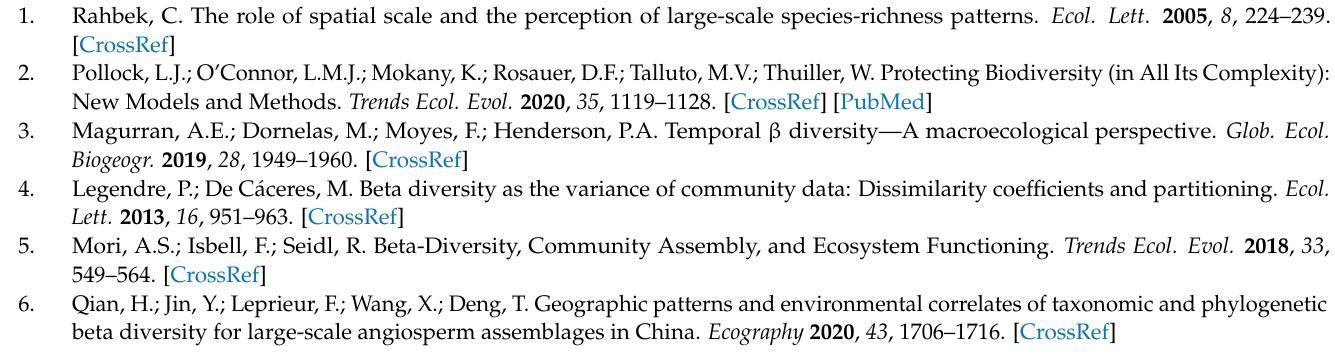
Figure S3: Partial response for 40–60 cm edaphic factors on trees’ GDM; Figure S4: Partial response for 60–100 cm edaphic factors on trees’ GDM; Figure S5: Partial response for 0–20 cm edaphic factors on shrubs’ GDM; Figure S6: Partial response for 20–40 cm edaphic factors on shrubs’ GDM; Figure S7: Partial response for 40–60 cm edaphic factors on shrubs’ GDM; Figure S8: Partial response for 60–100 cm edaphic factors on shrubs’ GDM; Figure S9: Partial response for 0–20 cm edaphic factors on herbs’ GDM; Figure S10: Partial response for 20–40 cm edaphic factors on herbs’ GDM; Figure S11: Partial response for 40–60 cm edaphic factors on herbs’ GDM; Figure S12: Partial response for 60–100 cm edaphic factors on herbs’ GDM; Table S1: Species composition and dominant species of different vegetation community at Nanling